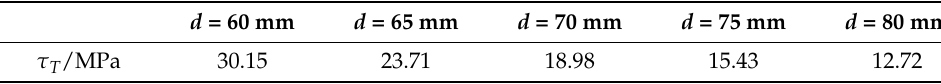
Table 4. Calculation results of torsional shear stress τ T .